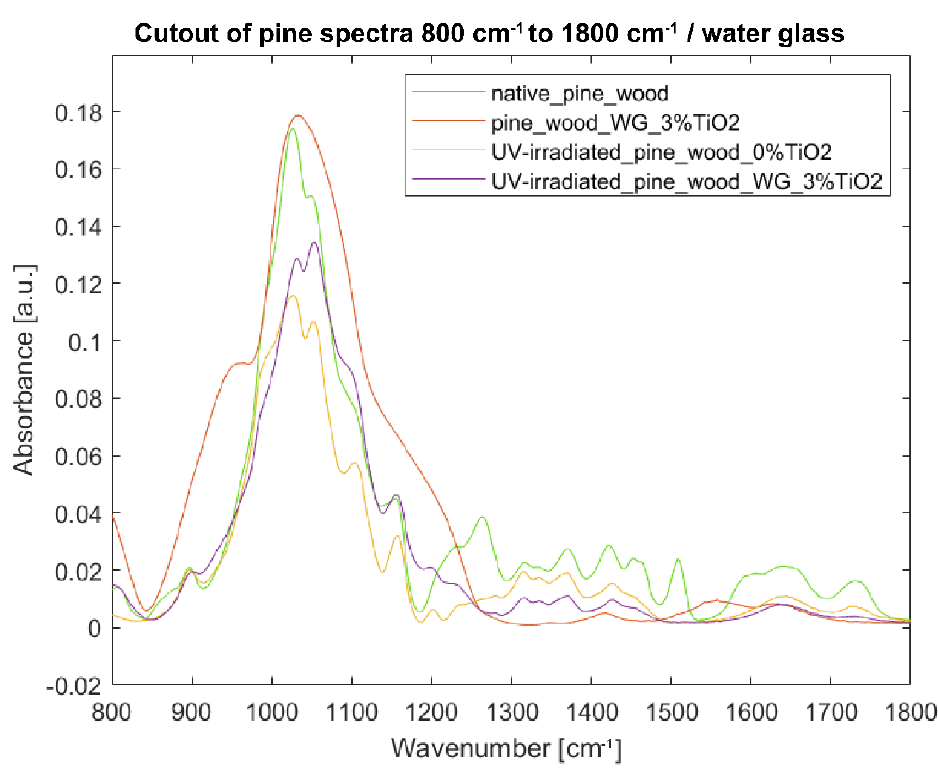
Figure 14. FTIR-ATR spectra of pine wood samples in the fingerprint region 800 – 1800 cm − 1 : (green) reference sample of native pine wood, (red) pine wood with 3% TiO 2 water glass coating, (yellow) UV-irradiated pine wood without TiO 2 coating, and (purple) UV-irradiated pine wood with 3% water glass TiO 2